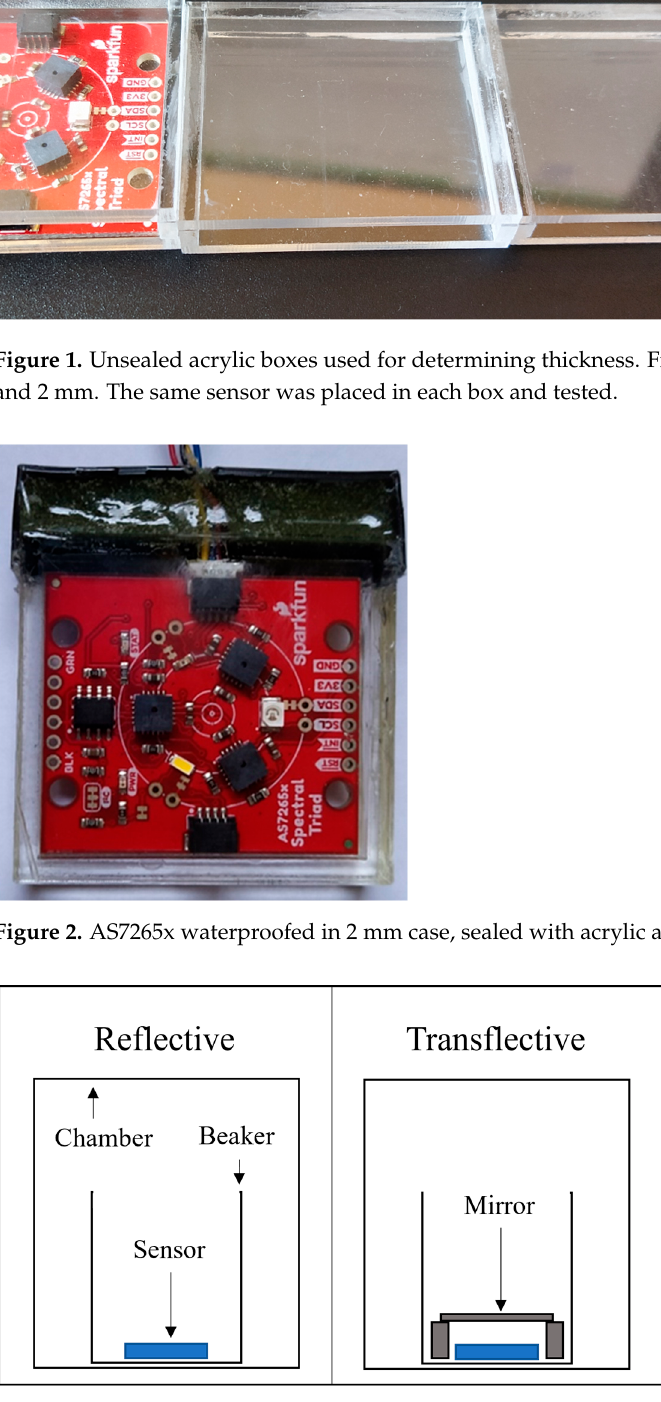
Figure 3. The experimental setup for testing the effectiveness of the reflective and transflective spectrophotometric techniques.